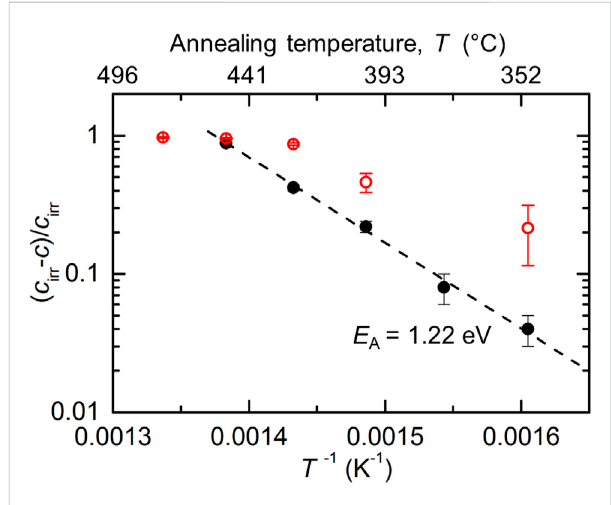
FIGURE 9 Arrhenius-plot of the normalized dissolved volume fraction of clusters ( c irr -c)/ c irr as function of the inverse absolute temperature for the present weld (empty red circles) and a western-type RPV steel (Ulbricht et al., 2006) (black